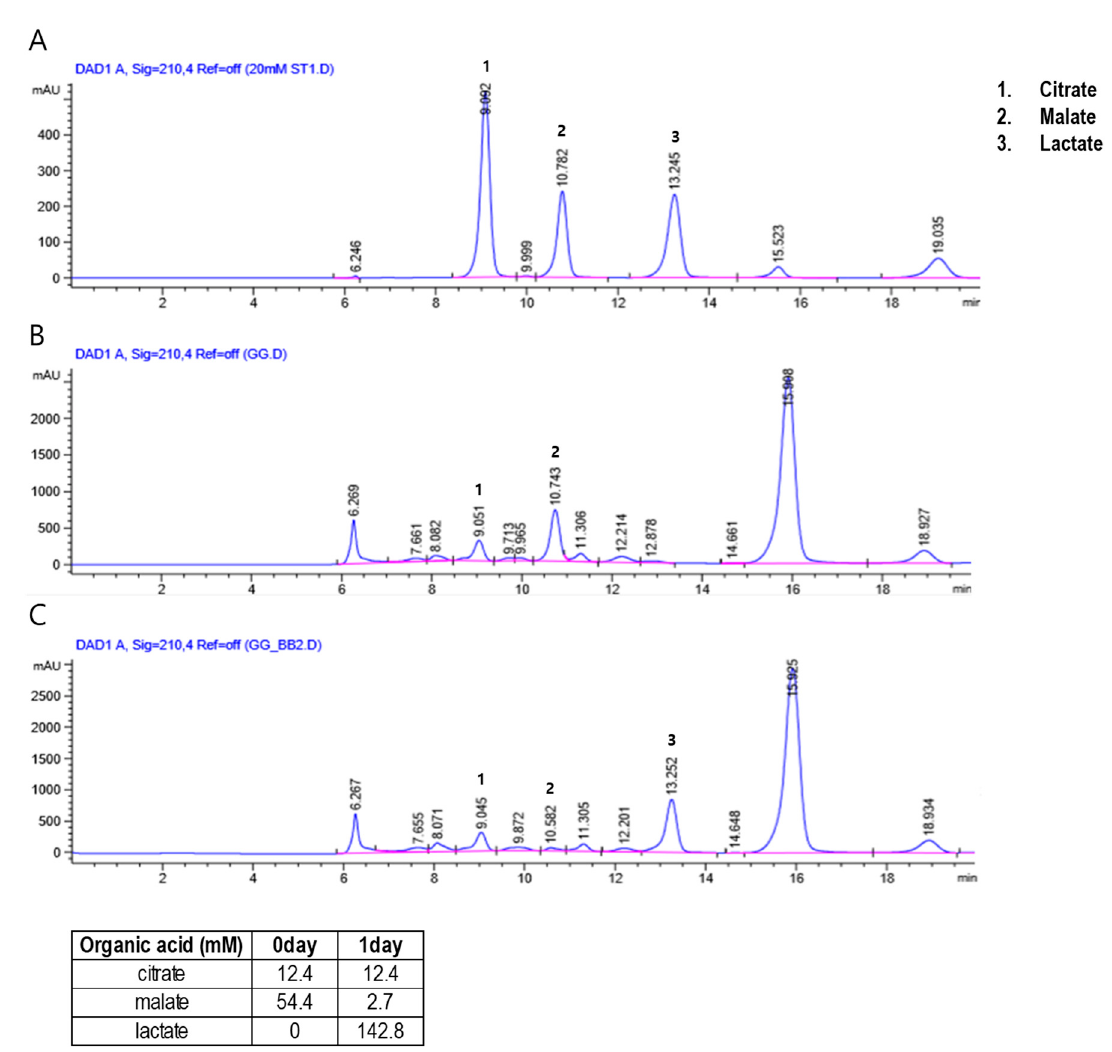
Figure 1. High-performance liquid chromatography (HPLC) chromatograms showing the content of (1) citrate, (2) malate, and (3) lactate in the standard solution used for calibration ( A ), and the levels of Puerariae Radix ( B ) and fermented Puerariae Radix ( C ) in the herbal preparations. 3.2. Effects of PR and fPR on the Body Weight, Liver Weight, and Intestinal and Total Fat Weights in the HFD+F Group